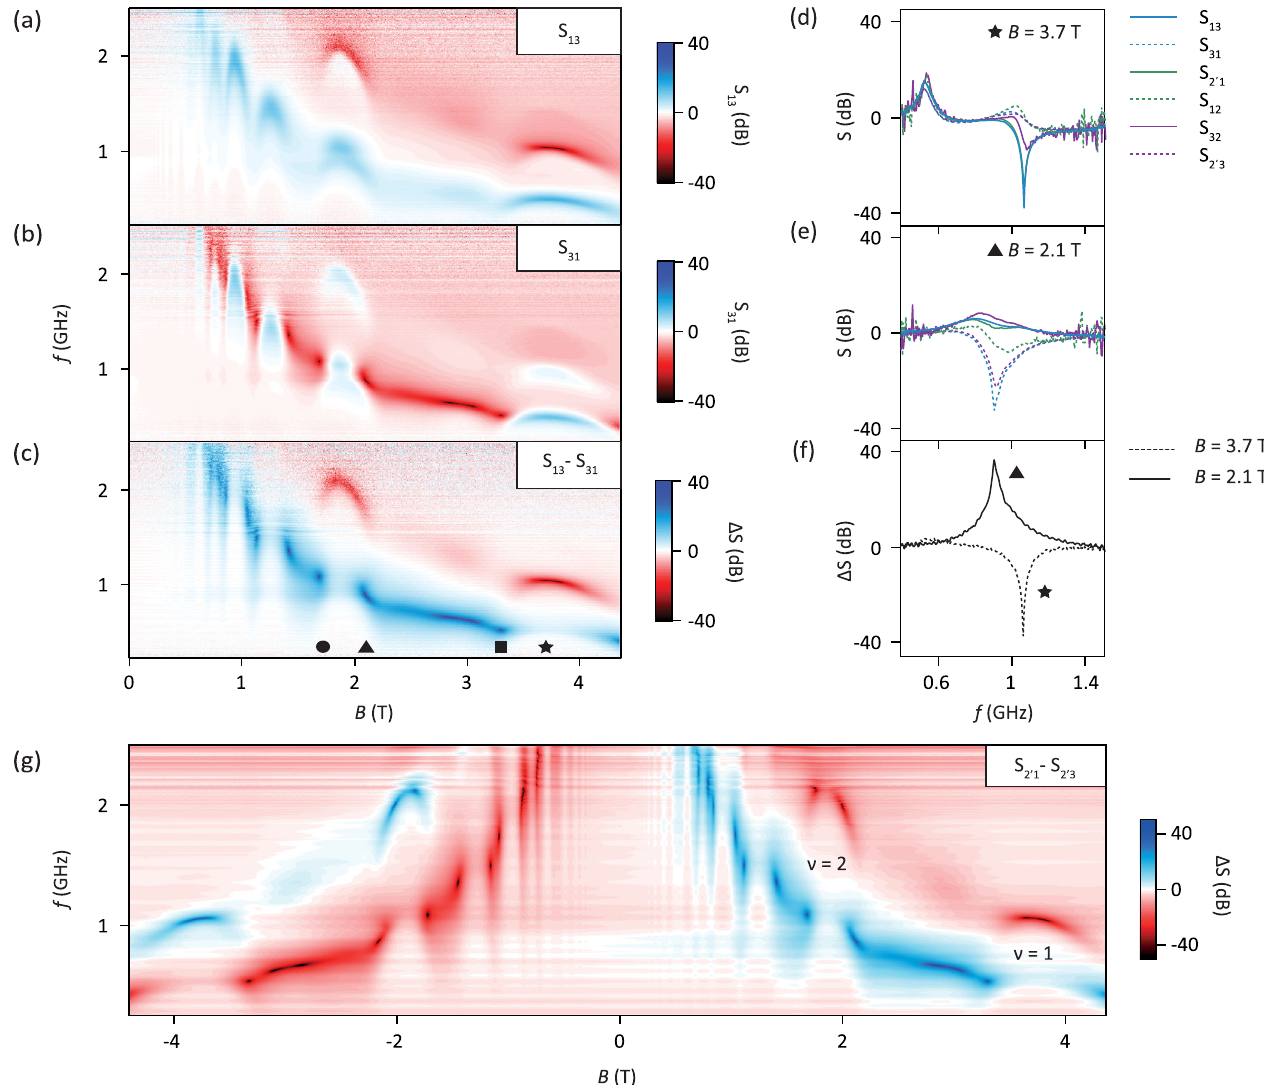
FIG. 3. Nonreciprocal response of the quantum Hall circulator. (a,b) Port transmission S 13 and S 31 with frequency and magnetic field. All measurements have been normalized to the gain-corrected background at B ¼ 0 [shown in Fig. 2(d)], which defines the 0 dB point on the color scale. (c) Microwave response S 13 – S 31 showing strong frequency and B -dependent nonreciprocity. (d,e) Full combination of transmission S parameters, taken at B fields indicated by the symbols in (c). (f) Cuts through the color scale data in (c), demonstrating forward and reverse circulation. (g) Isolation, Δ S ¼ S 2 0 1 - S 2 0 3 , measured at positive and negative magnetic fields. Note that the positions of features are symmetric about the B ¼ 0 axis, but with opposite sign Δ S